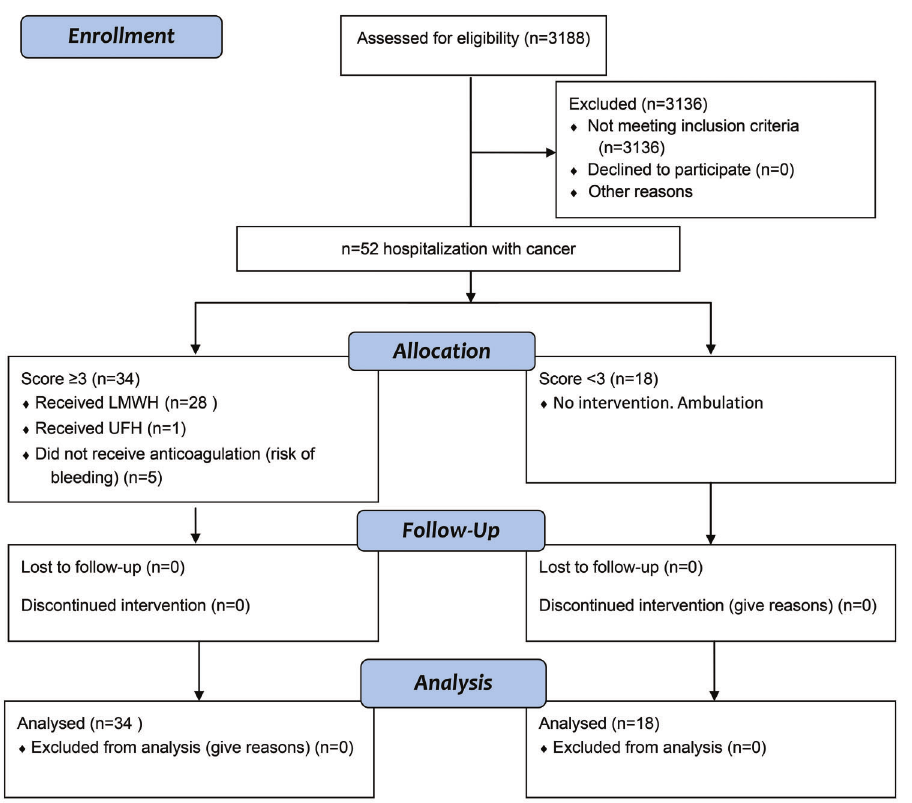
Figure 1 - Consort flow